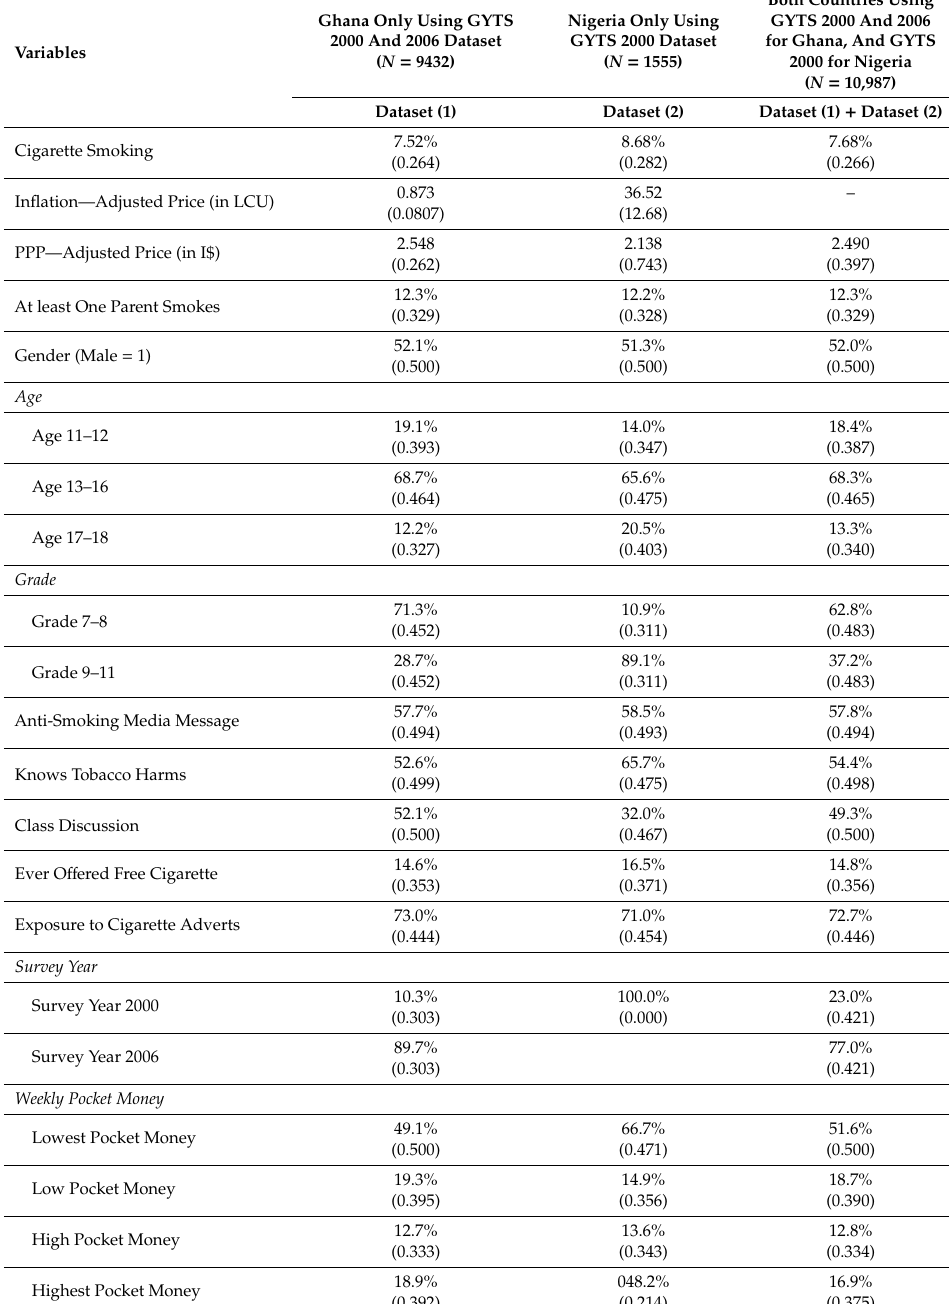
Table 1. Characteristics of youth (ages 11–18) for a 30-day cigarette smoking (standard deviations in